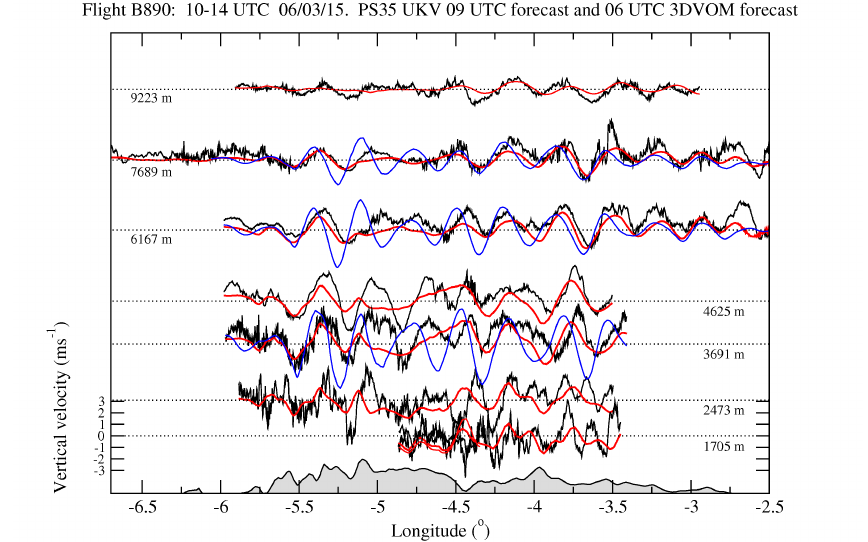
Figure 6. Comparisons of model vertical velocity with Facility for Airborne Atmospheric Measurement (FAAM) observations on 6 March 2015. The observations are shown in black (ms − 1 ) along the horizontal flight legs with the underlying orography. The forecast vertical velocity from the UKV model using the ENDGame core, initiated at 09 UTC, are interpolated onto the aircraft trajectories, shown in red. Hourly forecast data are selected according to the closet hour to the mid-point time of each aircraft leg. Also shown are vertical velocities from the 06 UTC 3DVOM forecast (blue) valid at 12 UTC along three of the aircraft legs.